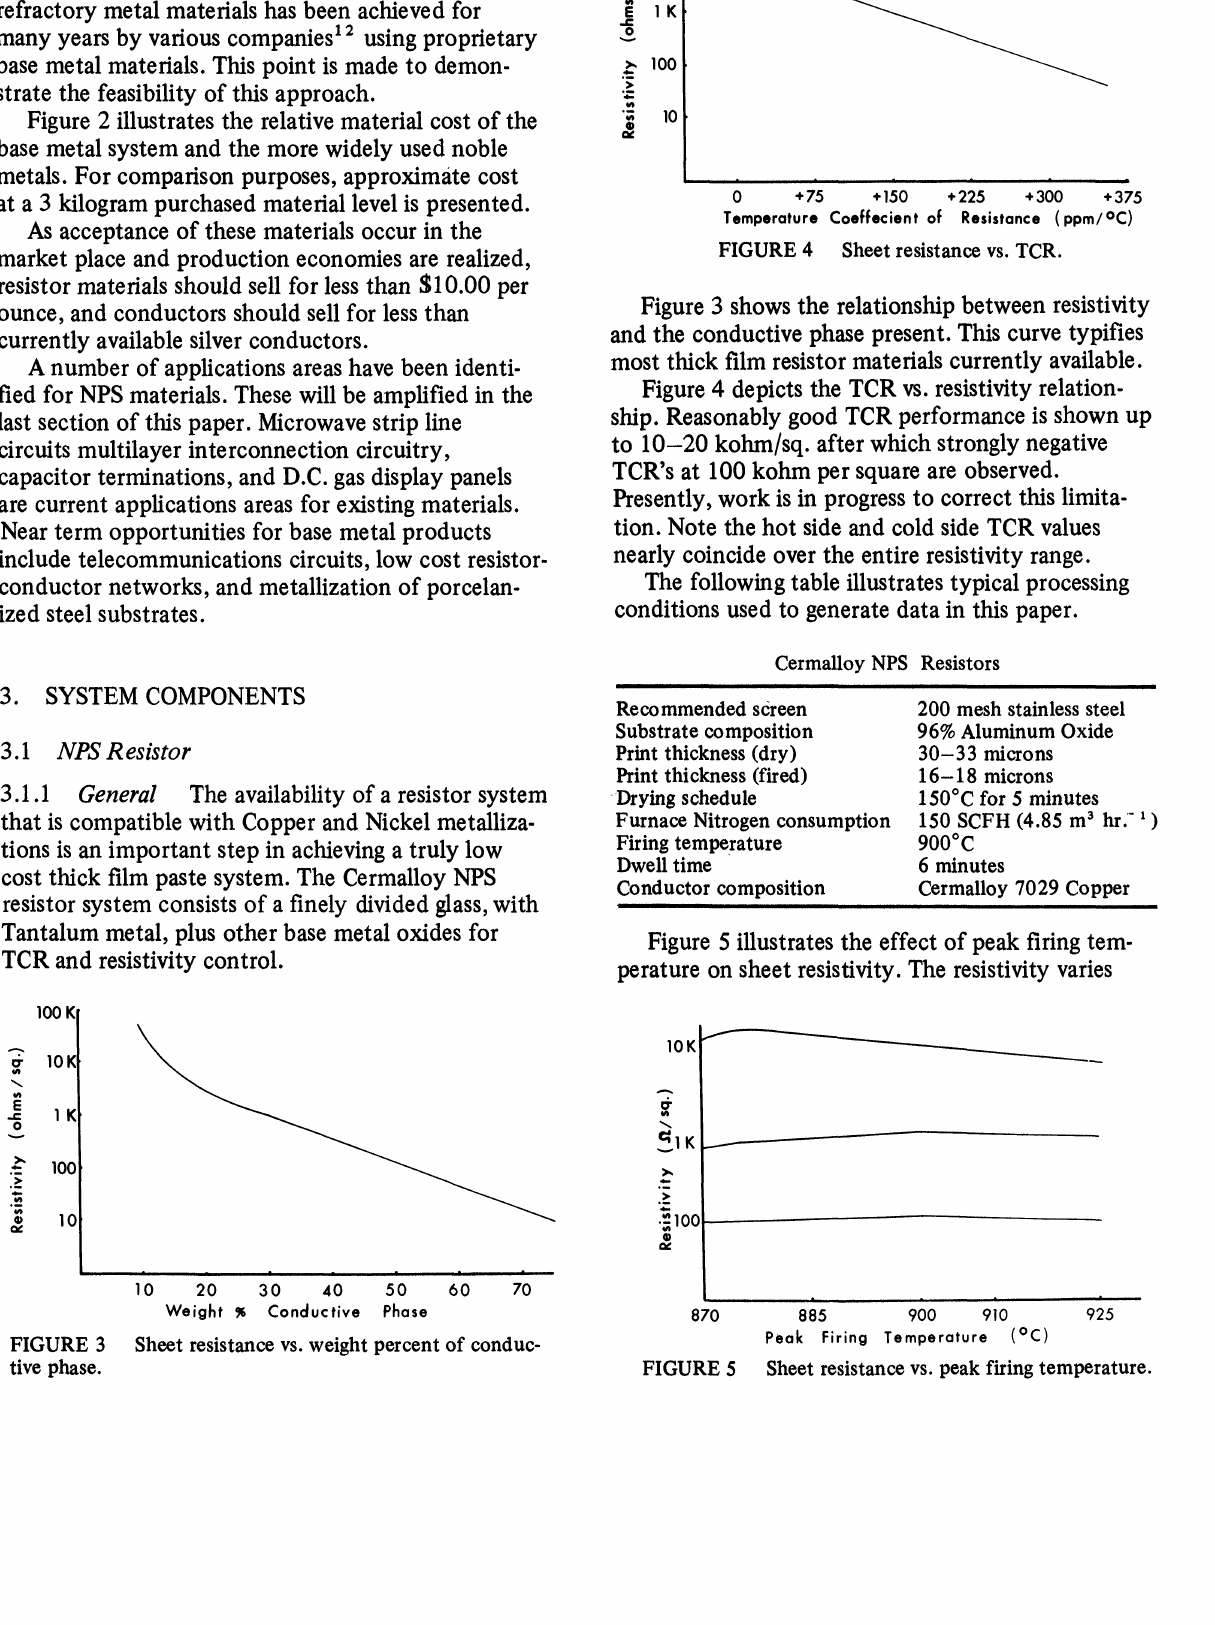
Weight Conductive Phase FIGURE 3 Sheet resistance vs. weight percent of conduc- tive phase.